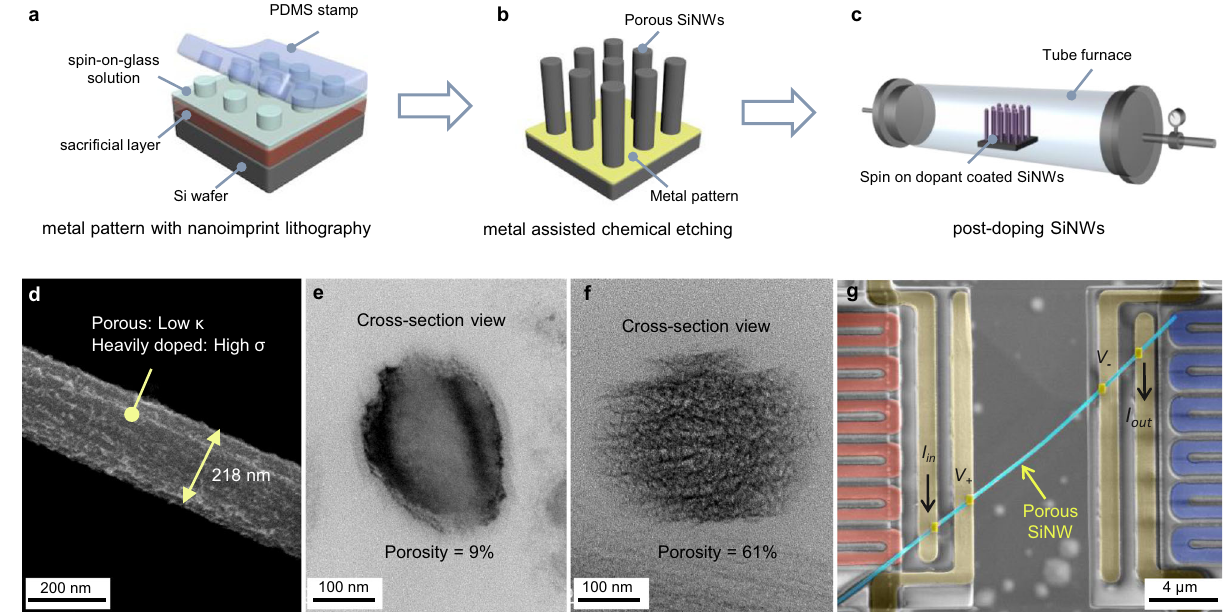
Fig. 1 SiNW fabrication, morphology, and thermoelectric measurement with suspended microdevice. Schematic drawing showing the sample fabrication process: a nanoimprint lithography (NIL) method to pattern metals, b metal-assisted chemical etching (MACE) to fabricate porous Si nanowire (SiNW) array, c post-doping (PD) SiNW arrays with a spin-on dopant (SOD) and high-temperature annealing (see details in Supplementary Note 2 and Supplementary Figs. 3 – 5). d SEM image of the as-fabricated porous SiNW. TEM images showing the cross-section view of two SiNWs with a porosity of e 9% and f 61%. g False-color SEM image showing the suspended microdevice with a porous SiNW placed to bridge the gap of two membranes for thermoelectric properties measurements. The Pt serpentine electrical leads marked with red and blue color indicate heating and sensing side thermometers, respectively. The electrical resistance of the individual nanowires is measured using the four-probe method, and the Seebeck coef fi cient is measured simultaneously with the thermal conductivity measurements. Table 1 Measured properties of SiNWs with varying porosity and doping levels investigated in this study. Starting wafer ( p , σ , κ